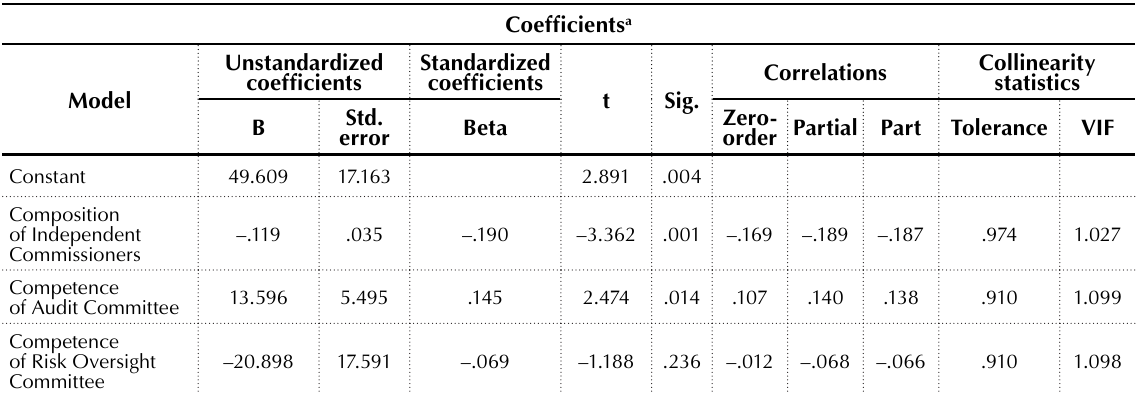
Table 3. Multicollinearity statistics test results, multiple linear regression test results, and T-test statistic